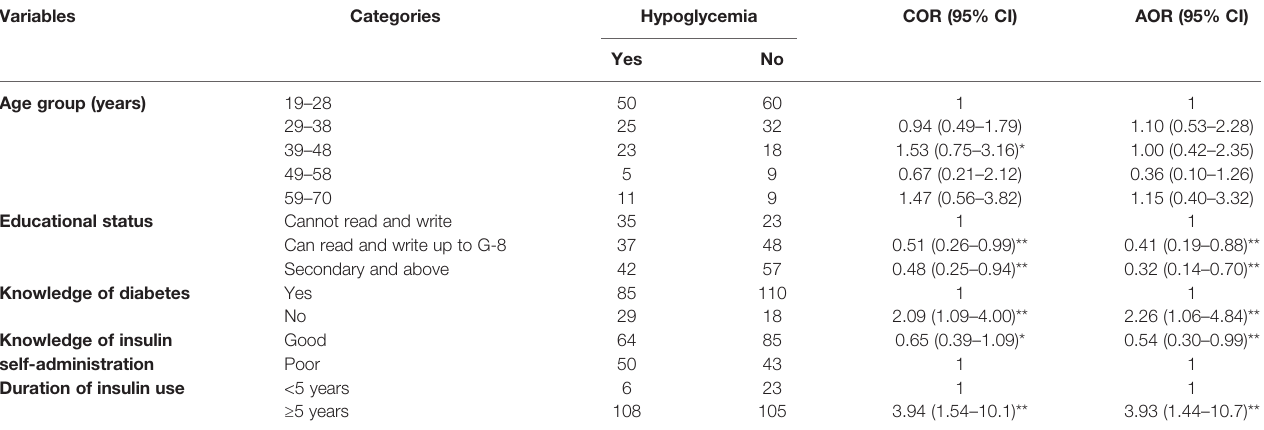
TABLE 4 | Factors associated with hypoglycemia among type 1 diabetes patients at metu karl heinz referral hospital in ethiopia.